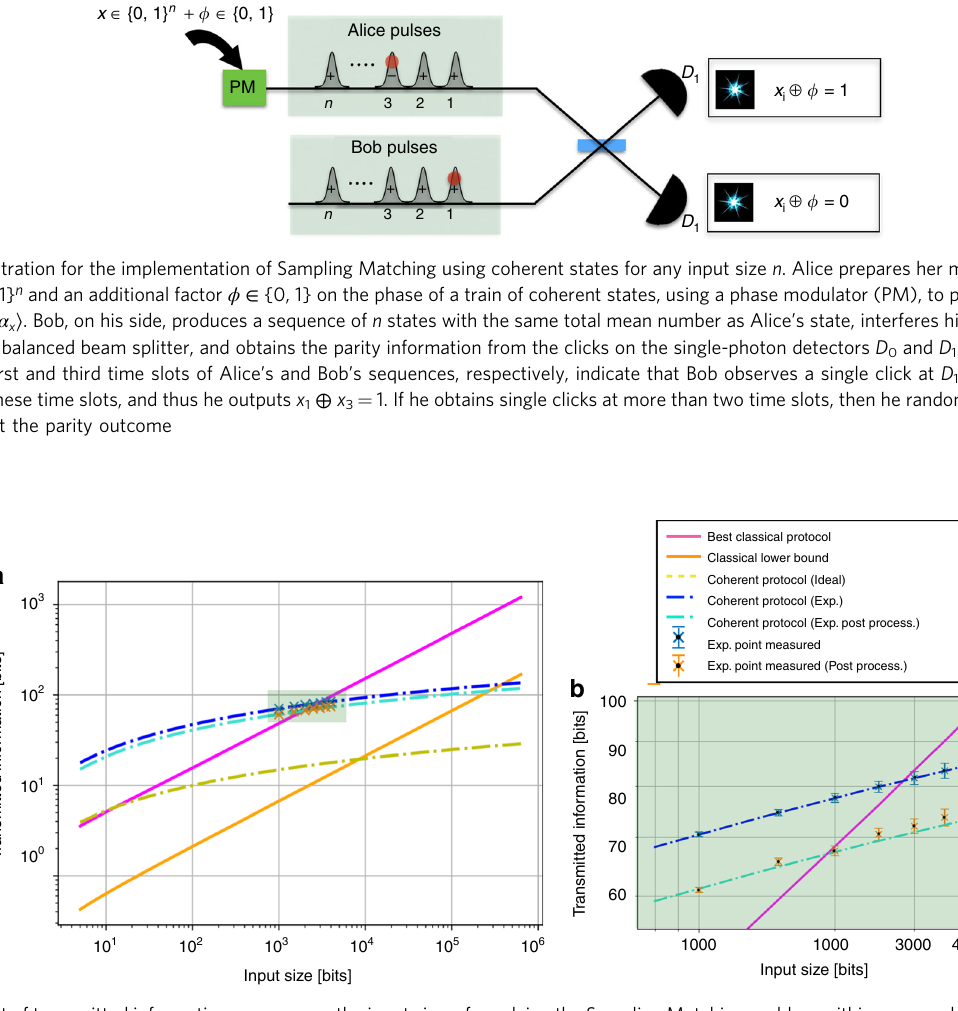
Fig. 4 Log – log plot of transmitted information resource vs. the input size n for solving the Sampling Matching problem within error probability p error = 0.1. In panel a , we compare the optimal classical protocol, the classical lower bound, and the quantum protocols in the ideal setting, in the practical setup with the experimental parameters of Table 1, and in the post-selected case where Bob only outputs a parity outcome when he obtains at least two single clicks in the protocol run. For the last two protocols, we also show the experimental results obtained with the setup of Fig. 5, for input sizes between 1000 and 4000. These results are also shown more clearly in panel b that focuses on this region. The optimal mean photon number per pulse in each case, as well as other parameters, is given in Table 2. The error bars for the experimental points refer to the standard deviation, which primarily comes from the error in estimating the mean photon number per pulse. We see that for the experiments implementing the standard and post-selected protocols, for input size above 3000 and 2000, respectively, our results outperform the best classical protocol hence demonstrating the obtained quantum advantage